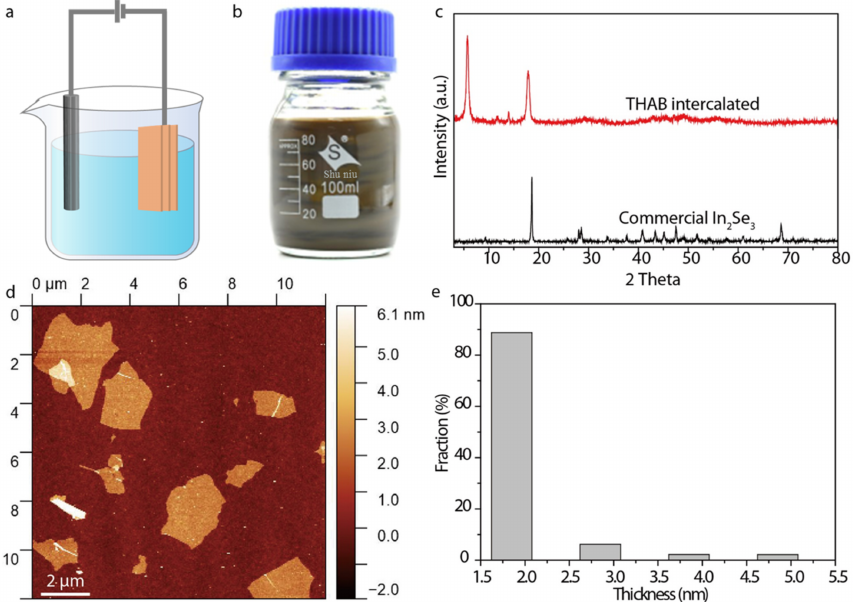
Figure 1. Synthesis and characterizations of In 2 Se 3 nanosheets. ( a ) Schematic of the electrochemical exfoliation of the layered In 2 Se 3 into nanosheets. ( b ) Photograph of In 2 Se 3 dispersion in DMF. ( c ) XRD patterns of the THAB-intercalated bulk In 2 Se 3 compared with commercial In 2 Se 3 . ( d ) Atomic force